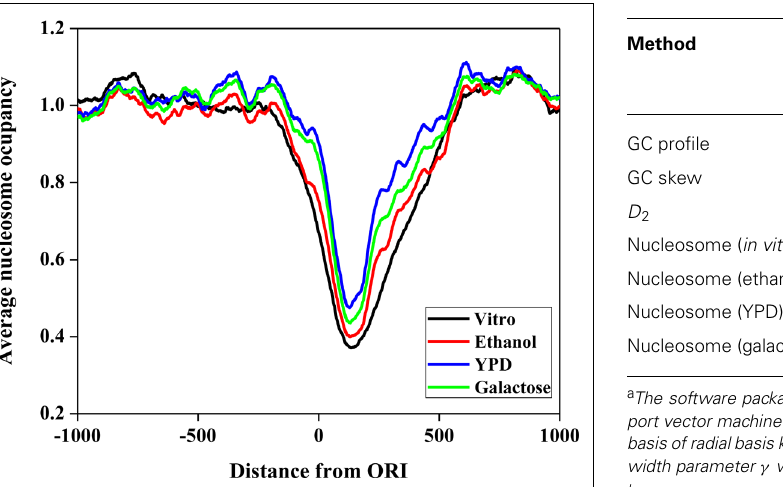
Table 1 | Predicted results of different parameters using a support vector machine a